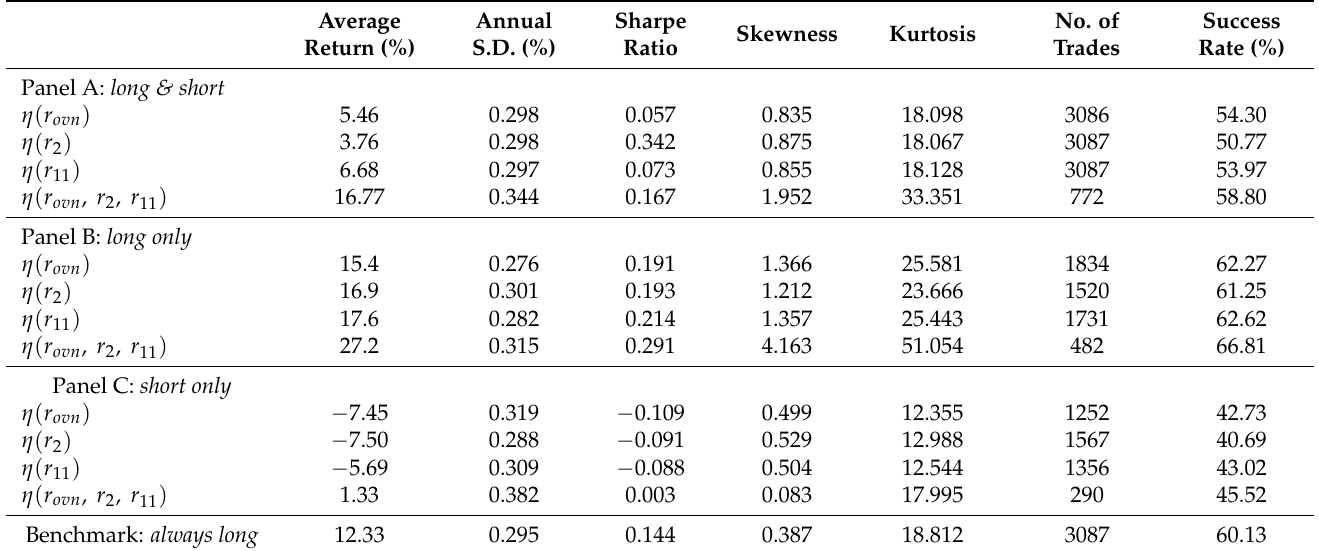
Table 8. Results from MIM-based trading